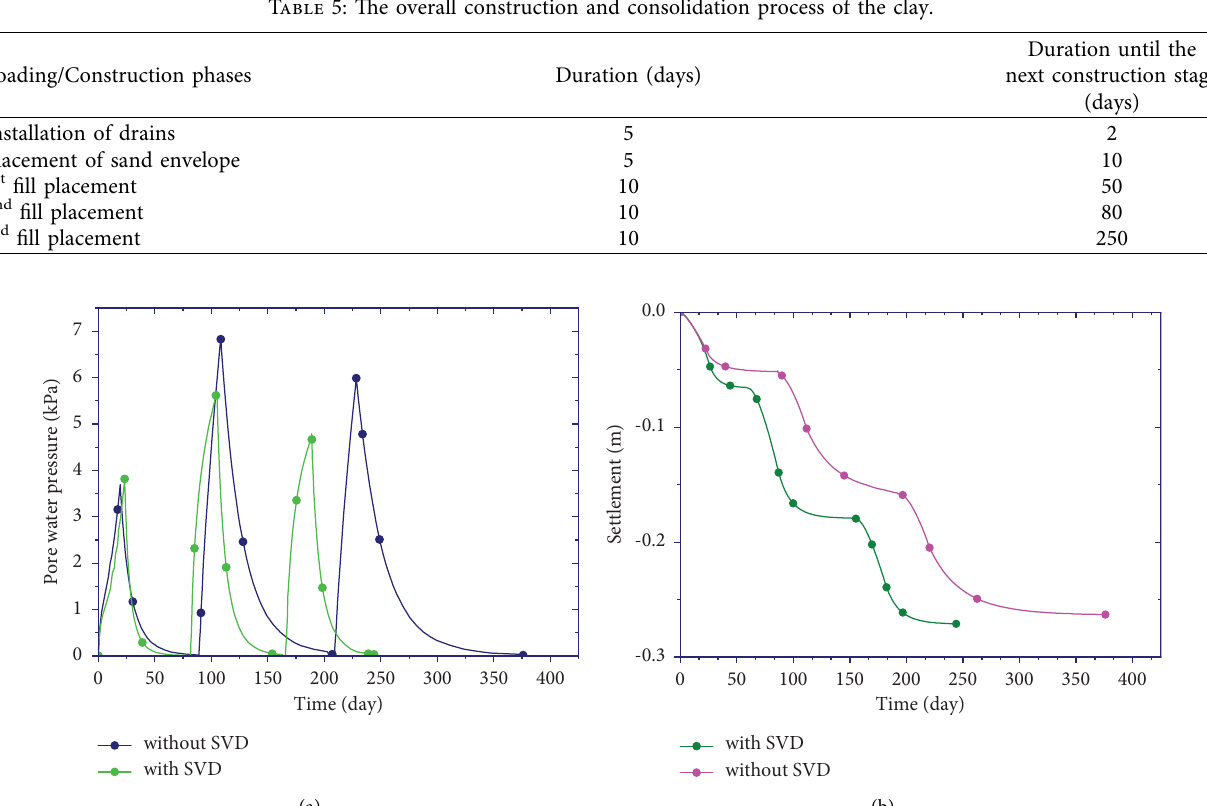
Table 5: Te overall construction and consolidation process of the